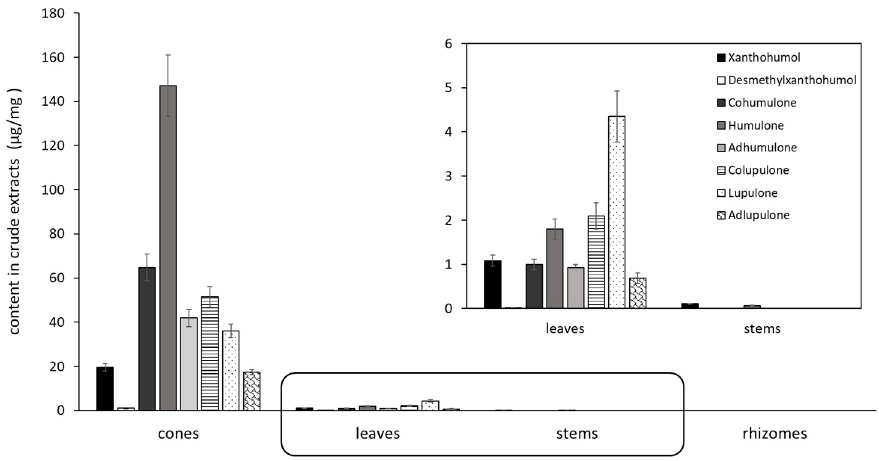
Figure 3. Content of prenylated chalcones and acylphloroglucinols in crude hydro-alcoholic extracts of different hop parts (in µg/mg) ( n = 3, mean ± SD).